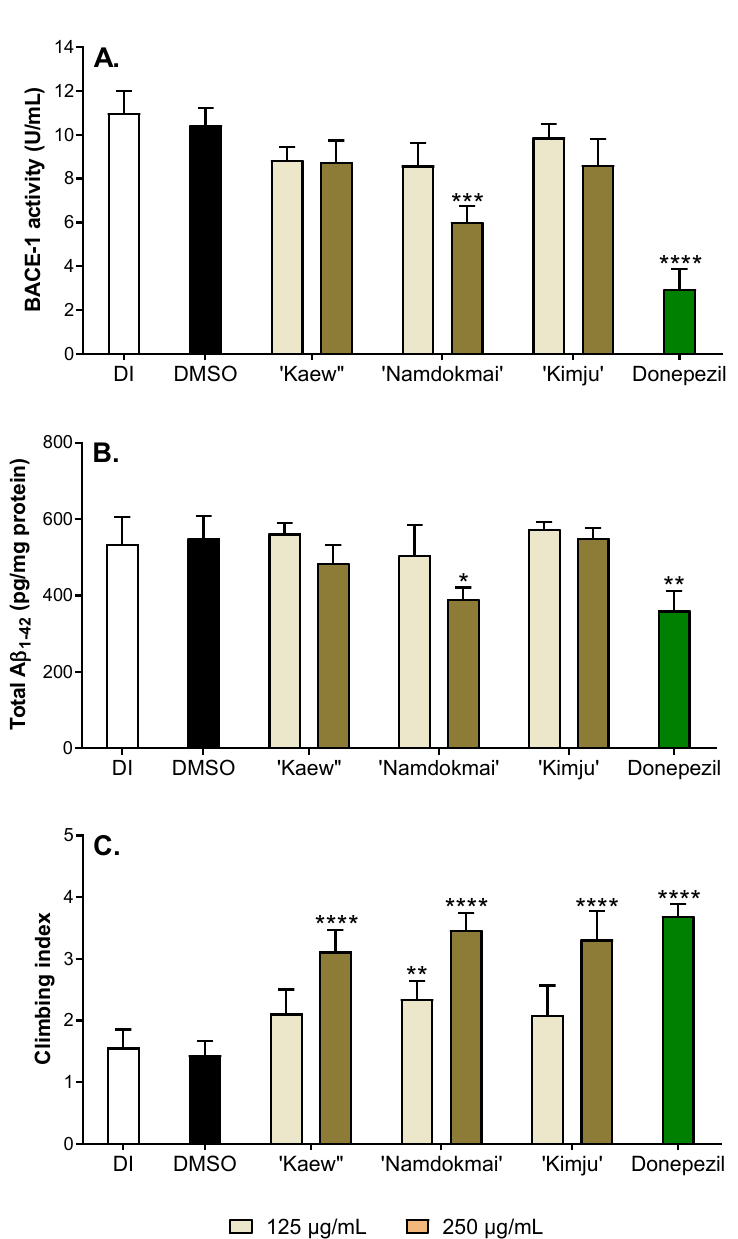
Figure 5. Effect of the fruit extracts ( M. indica ‘Kaew’, M. indica ‘Namdokmai’, and P. guajava ‘Kimju’) on ( A ) β -secretase (BACE-1) activity, ( B ) total amount of amyloid beta 1–42 (A β 1–42 ) level, and ( C ) fly climbing index. One- to two-day-old flies expressing human amyloid precursor proteins (APPs) and BACE-1 were treated with deionized water (DI), dimethyl sulfoxide (DMSO, solvent control) and selected fruits extracts (125 or 250 µ g/mL) for 30 days before assayed for BACE-1, A β 1–42 level or climbing index. * Significance at p < 0.05, ** significance at p < 0.01, and *** significance at p < 0.001 and **** significance at p < 0.0001 compared with a solvent control using one-way analysis of variance (ANOVA) followed by Tukey’s multiple comparisons test.